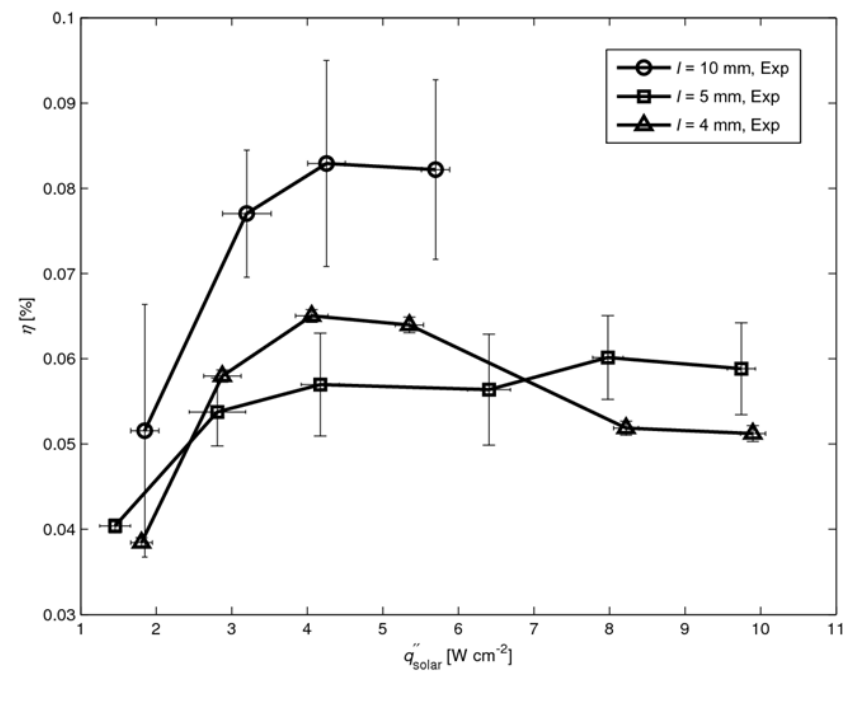
Figure 6. Efficiency η as a function of solar radiative flux for three modules with l = 4, 5, and 10 mm. Error bars indicating uncertainty of incident solar radiative flux and efficiency due to uncertain contact